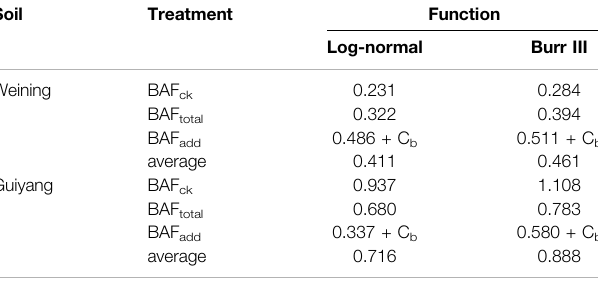
TABLE 2 | Soil Cd threshold calculated with two functions for two soil types. Soil